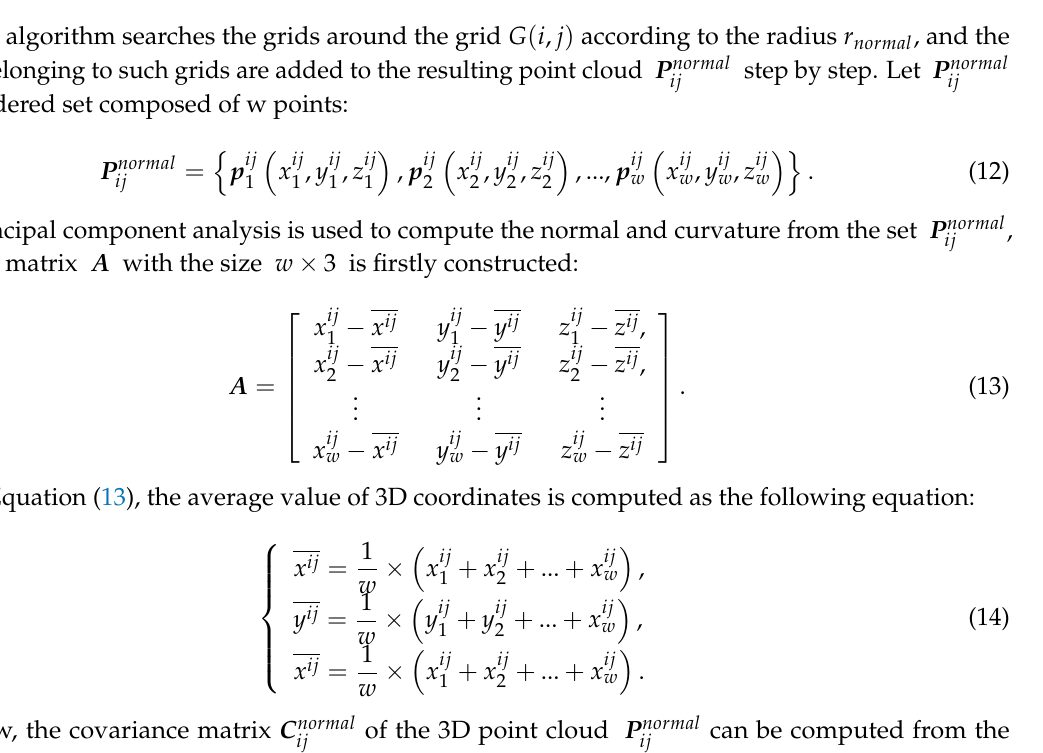
Figure 5. Flow chart of the algorithm for searching points around some